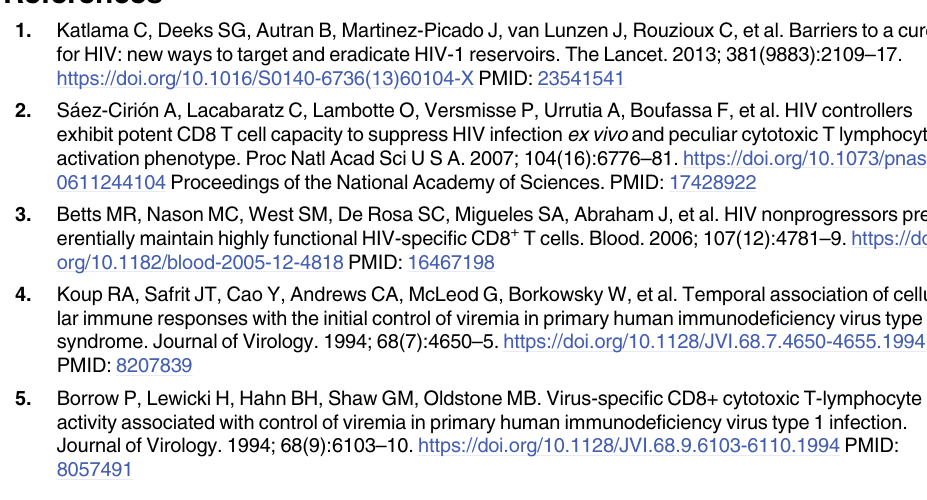
S2 Data. Raw data for supplementary figures in manuscript. Tables containing raw data of all supplementary figures. S3 Data. Group B vaccinated macaques scRNAseq metadata worksheet. Descriptive infor- mation and protocols for experiments, samples and data processing pipeline of single-cell RNA transcriptome